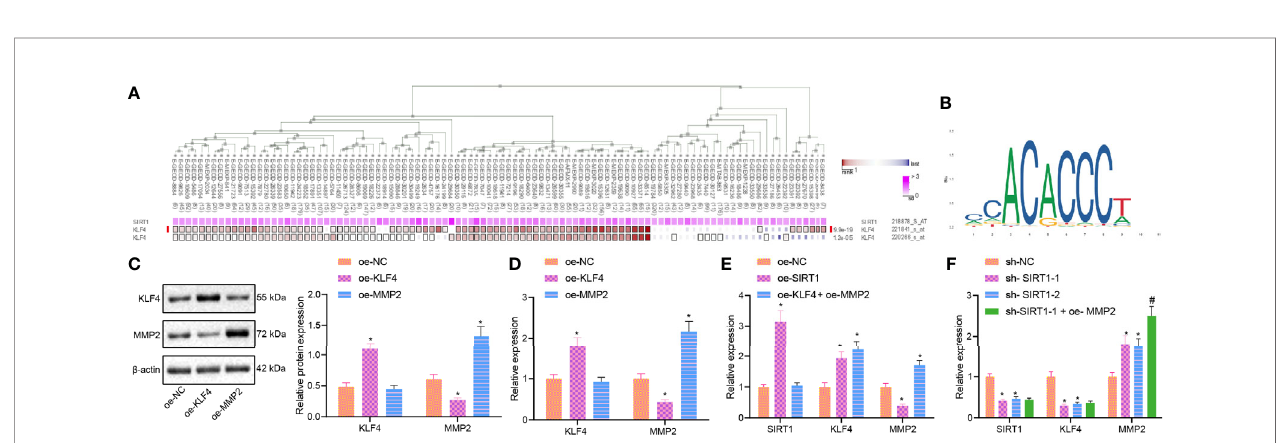
FIGURE 4 | SIRT1 regulates KLF4/MMP2 in sepsis. (A) , The co-expression of SIRT1 and KLF4 analyzed by MEM. (B) , The binding sites of KLF4 and MMP2 promoter regions predicted in JASPAR website. (C) , The expression of KLF4 and MMP2 measured by Western blot analysis. (D) , The expression of KLF4 and MMP2 determined by RT-qPCR. (E) , The expression of SIRT1, KLF4 and MMP2 determined by RT-qPCR. (F) , The expression of SIRT1, KLF4 and MMP2 determined by RT-qPCR. * p < 0.05 vs. oe-NC or sh-NC group. # p < 0.05 vs. sh-SIRT1-1 group. The measurement data were expressed as mean ± standard deviation. One-way ANOVA was used for the comparison among multiple groups, followed by Tukey ’ s post hoc